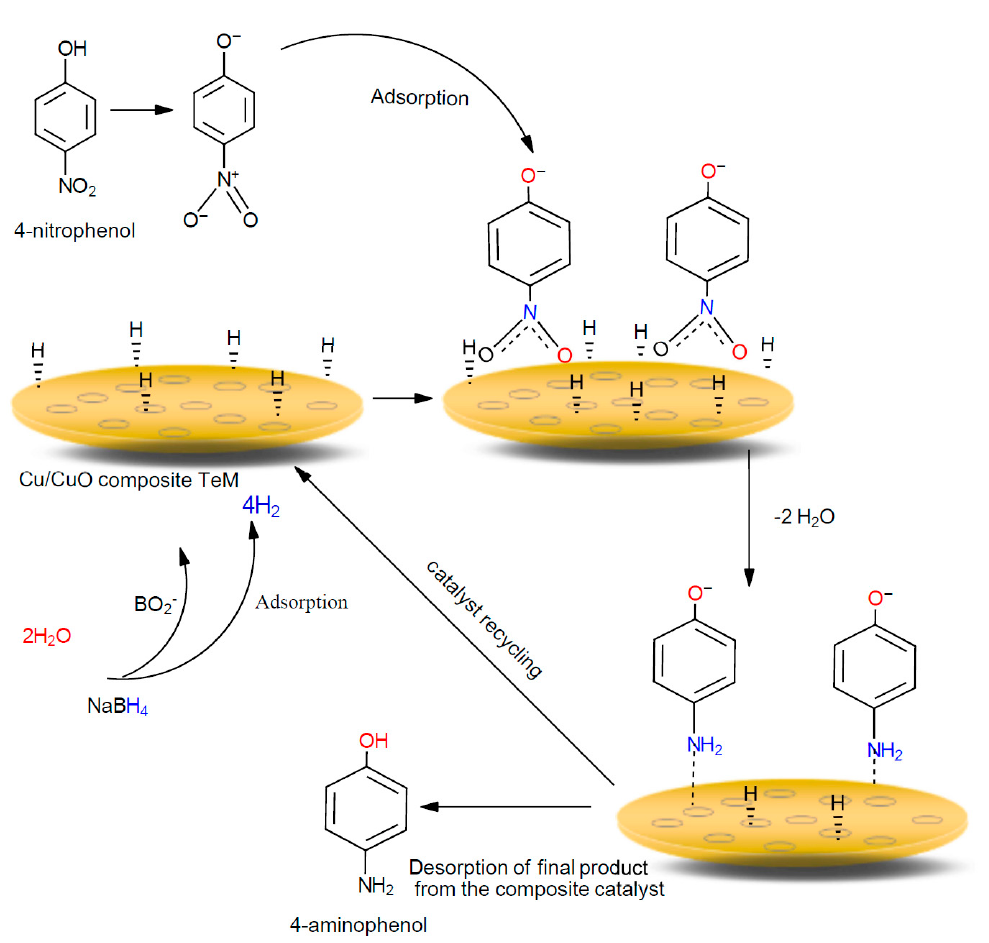
Figure 7. Schematic representation of 4-NP reduction on the surface of Cu/CuO composite TeM according to Langmuir–Hinshelwood mechanism.